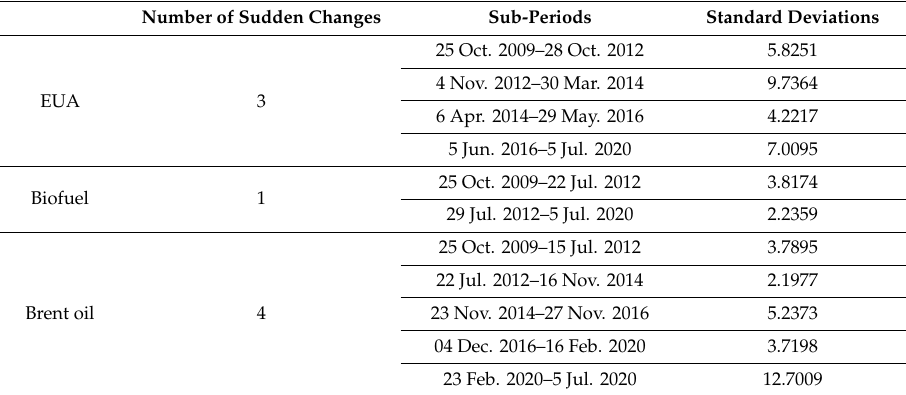
Table 2. Sudden change points identified by the ICSS algorithm and standard deviations.